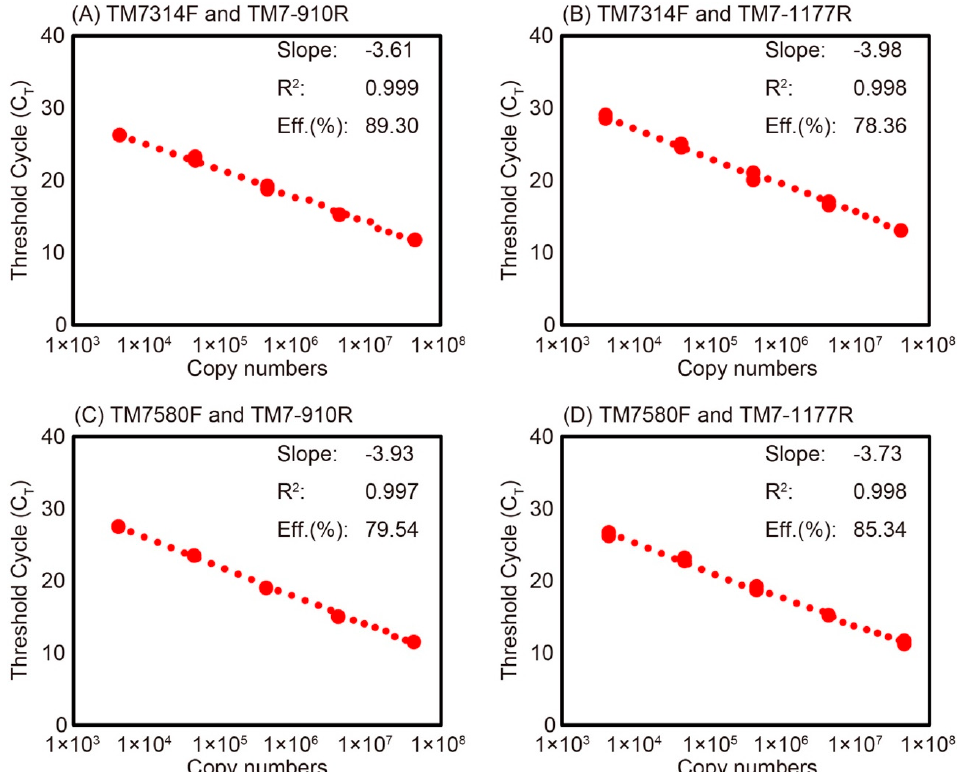
Figure 3. Standard curves of Saccharibacteria qPCR for the measurement of activated sludge samples using 10-fold serial dilutions of plasmid DNA carrying Saccharibacteria 16S rRNA genes and the four primer sets: TM7314F and TM7-910R ( A ); TM7314F and TM7-1177R ( B ); TM7580F and TM7-910R ( C ); and TM7580F and TM7-1177R ( D ). The slope, coefficient of determination (R 2 ), and amplification efficiency are also shown in the figures.